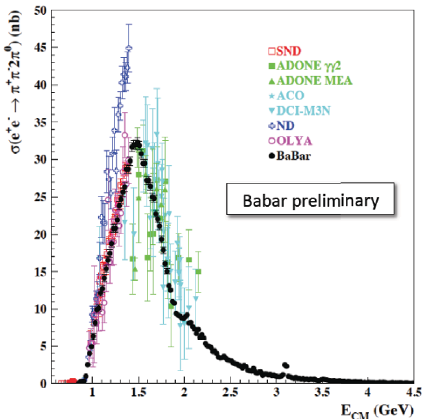
Figure 3. Babar measurement of the e + e − → π + π − π 0 π 0 cross section in comparison with published results from previous